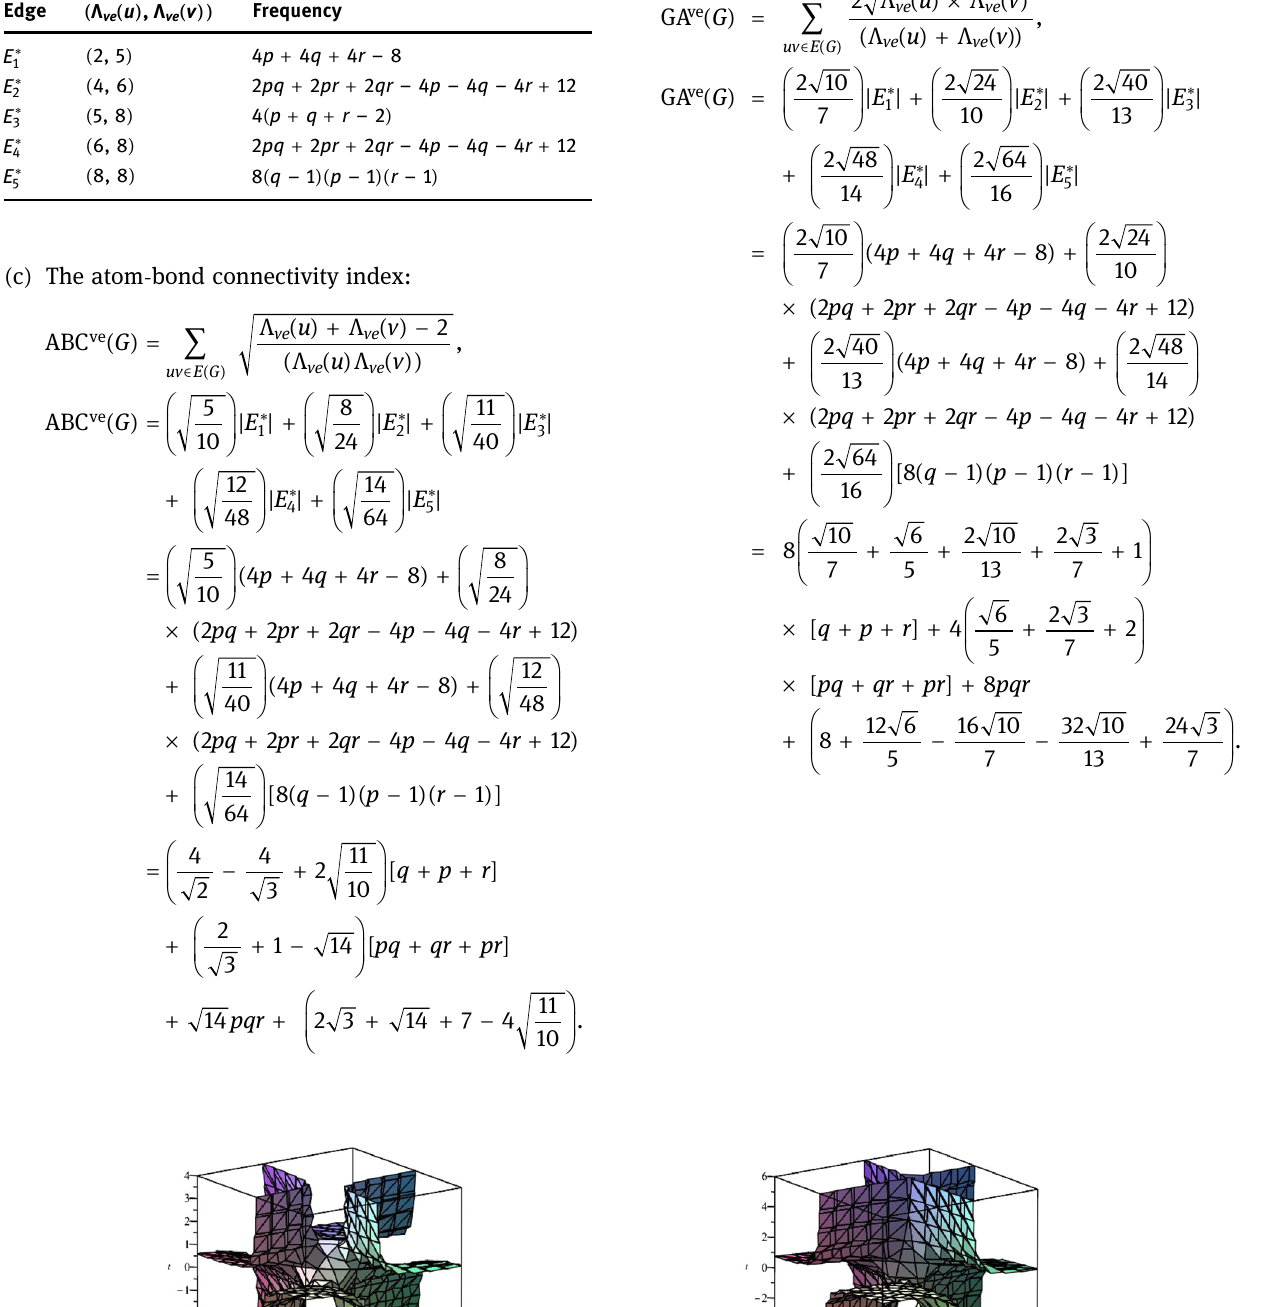
Table 3: Ve - degrees of end vertices of each edge of Cu O 2 Edge